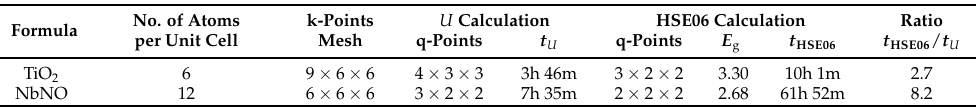
Table A2. Comparison of the computational costs of the one-shot U linear-response and HSE06 cal- culations for TiO 2 and NbNO. The ratio between the time for HSE06 ( t HSE06 ) and U ( t U ) calculations is given by t HSE06 / t U , and the band gaps E g calculated using HSE06 are also reported (in eV). U Calculation HSE06 Calculation Ratio Formula No. of Atoms k-Points per Unit Cell Mesh